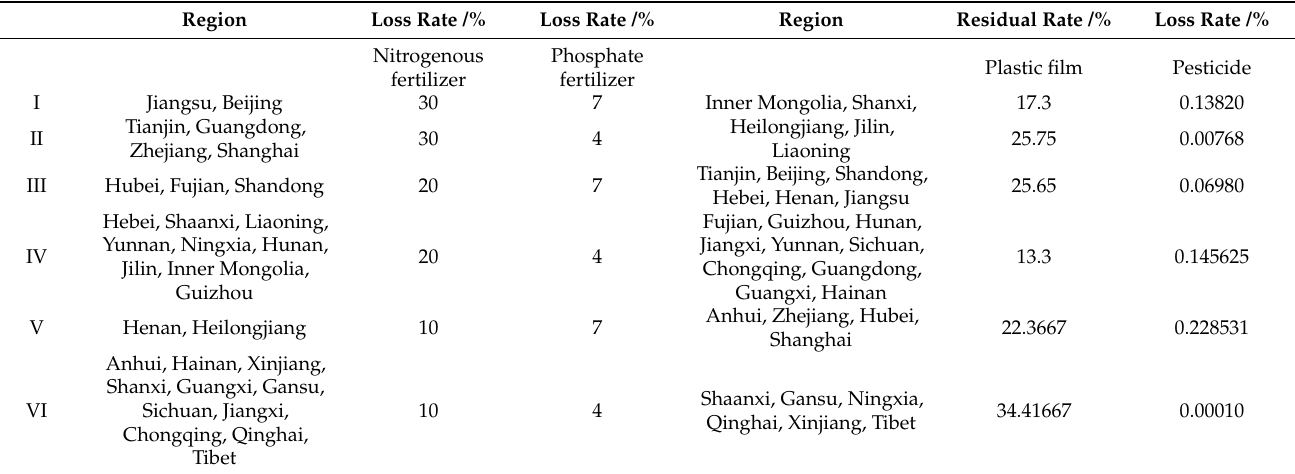
Table 2. List of product factors of